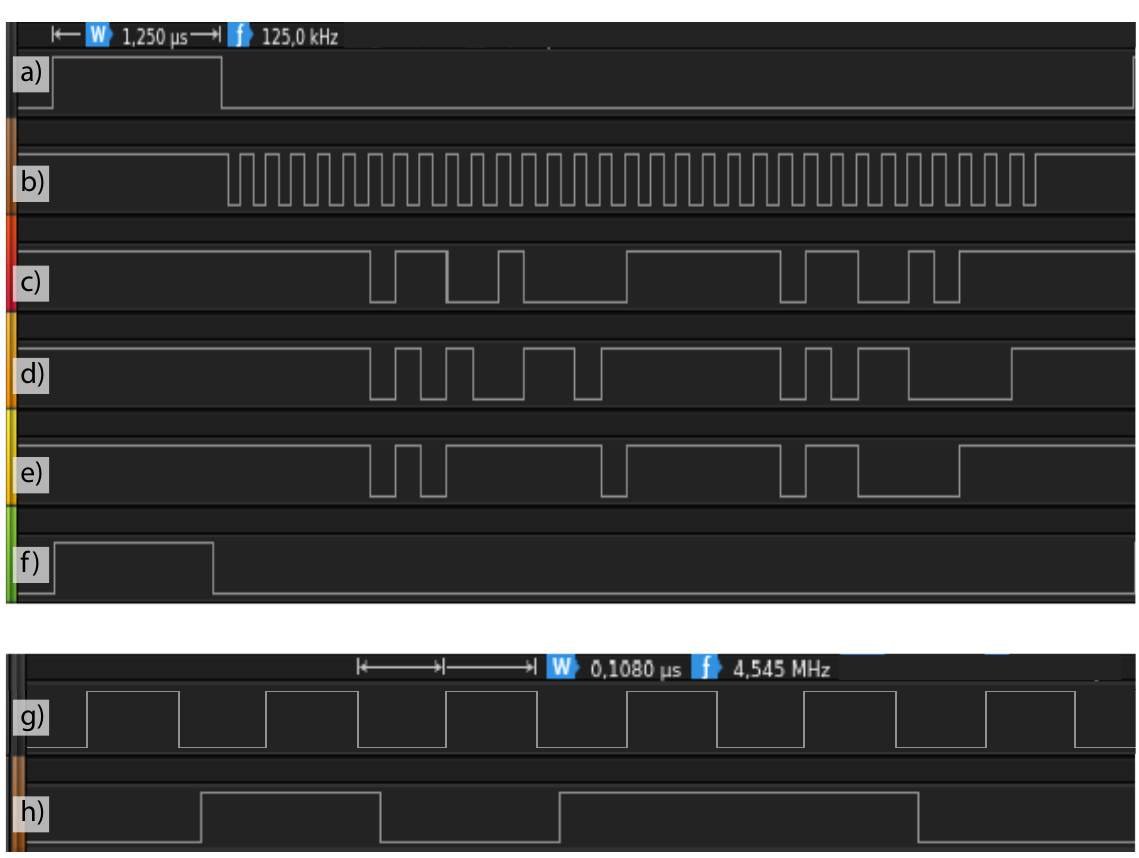
Figure 5. Signals a – f : Result of the generated firmware on a Beaglebone Black running the timing diagram from Figure 3 defined in the model as a 125 kHz sampling frequency for serial operation of the ADS8556 ADC. The signals were captured with a Saleae Logic Pro digital analyzer. In this case, the desired sampling frequency is matched exactly. The conversion start signal is used to determine whether the exact sampling frequency of 125 kHz is achieved. Signal a is the conversion start signal (CONVST_x in Figure 3) and is used to trigger a new conversion; this signal can be used to validate the timing of the generated firmware. Signal b is the SCLK signal, and Signals c – e are the data inputs (SDO_A-SDO_C), as mentioned in Figure 3. Signals g – h : Result of the generated firmware on a Beaglebone Black running the generated firmware for sampling SPH0641 microphones at a defined sample rate of 4.5 MHz. Due to the mismatch between clock frequency and the desired sampling frequency, the generator generates firmware for the closest high approximation at 4.545 MHz and provides feedback on the adjusted sample frequency to the user at compile-time. Signal g is the generated clock signal, and Signal h is the pulse-density-modulated input signal generated by the